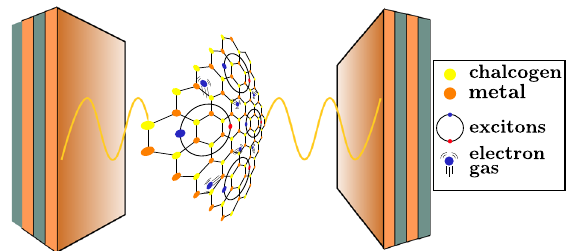
Fig. 1 Sketch of the system. Transition metal dichalcogenide monolayer in an open microcavity with adjustable cavity frequency. The hexagonal TMDC lattice hosts bound excitonic states (circles) and a gas of electrons (blue bearded dots). Yellow and orange dots are chalcogen and metal atoms,